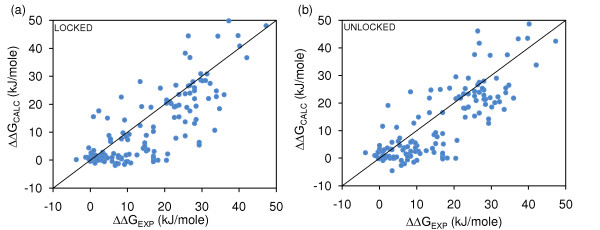
ΔΔG models for Locked and Unlocked interfacial sidechains, Minimal-HighSA. Binding models fit to ΔΔGEXP, for Minimal-HighSA repacking. (a) ΔGSC-ROT calculated for Locked interfacial sidechains (R2 = 0.61). (b) ΔGSC-ROT calculated for Unlocked sidechains (R2 = 0.64).